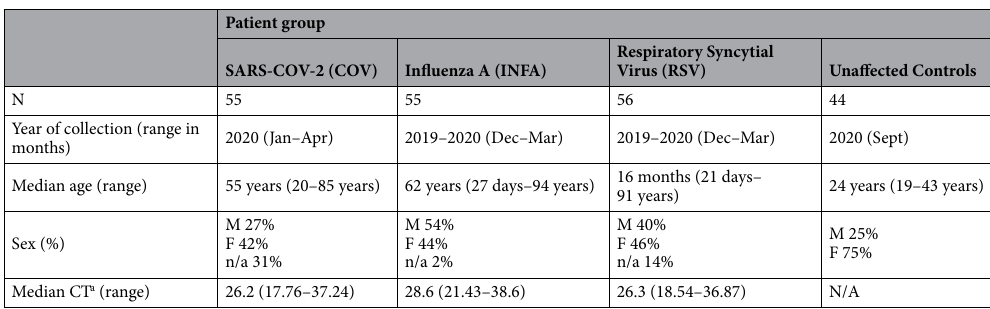
Table 1. Patient demographics. a PCR cycle threshold values